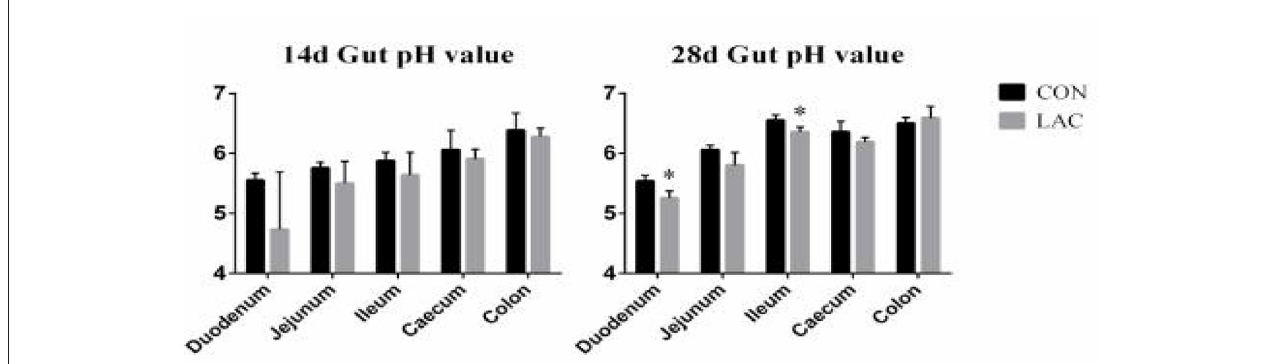
FIGURE 2 | Effects of Lactobacillus delbrueckii on intestinal pH in weaned piglets. N = 4. Label (*) mean significant difference between the CON group and the LAC group ( p < 0.05). CON, basal diet; LAC, basal diet with 0.1% Lactobacillus delbrueckii